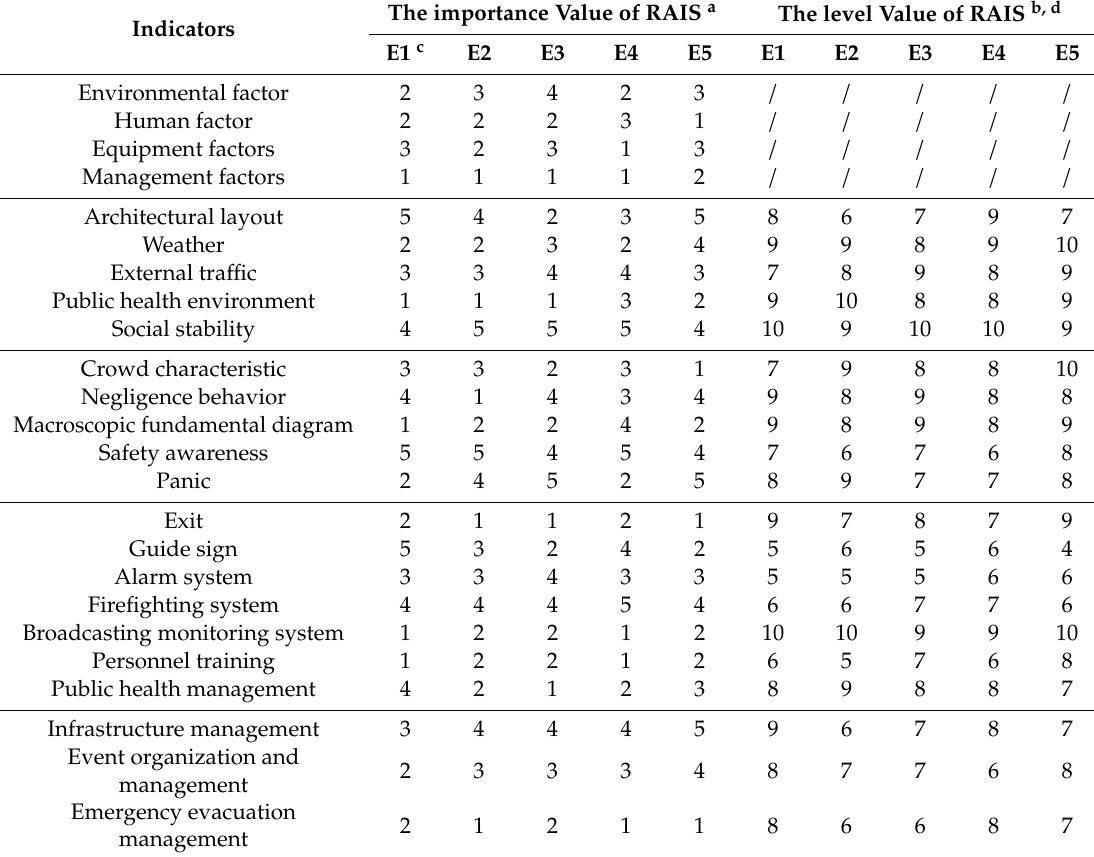
Table 3. Scores of Risk Assessment Index System (RAIS) by